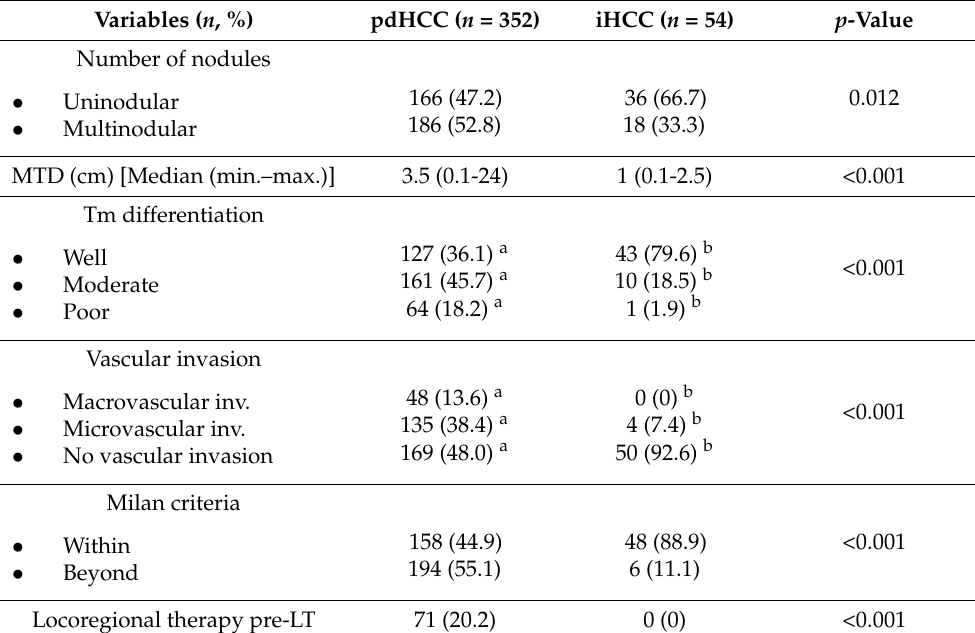
Table 2. Histopathological features of iHCC and pdHCC. Variables ( n ,